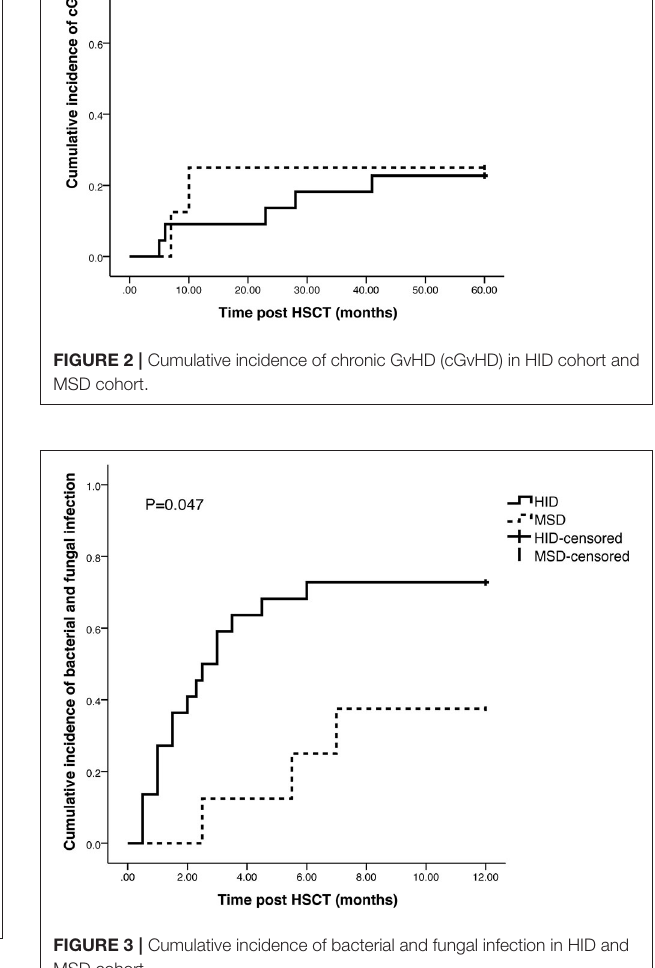
(77.3 vs. 37.5%, p = 0.037) ( Figure 4A ). In HID